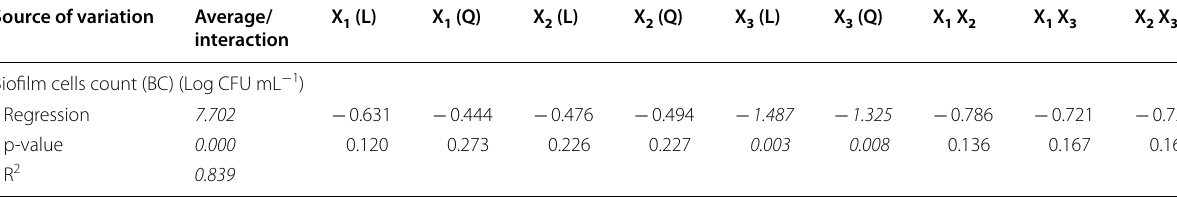
Significant values ( p < 0.05) are highlighted in